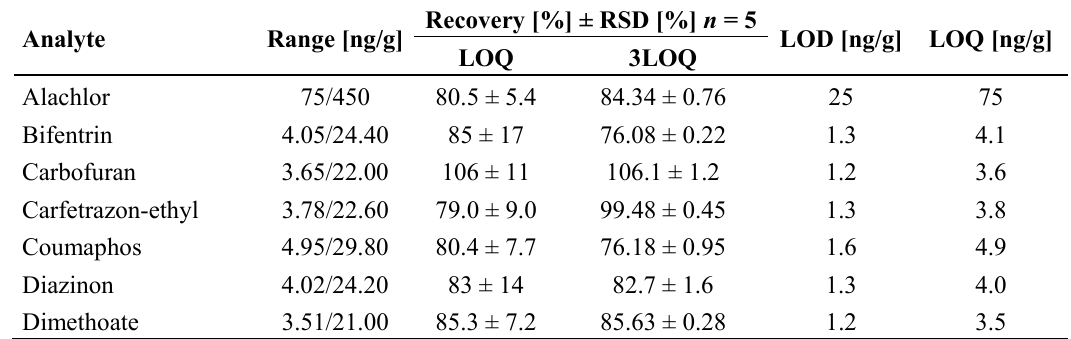
Table 1. Range of linearity, recovery of analytes, limit of determination and quantification (LOD and LOQ) of the modified analysis method of solvent extracts of honeybee